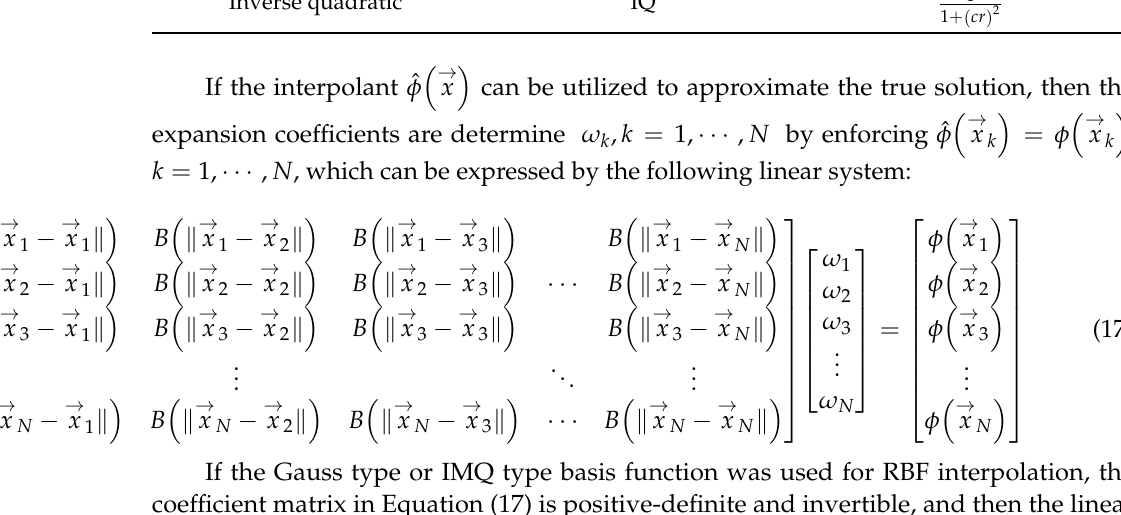
Table 1. Definitions of some infinitely differentiable radial functions, the shape parameter c controls their flatness. Name of RBF Abbreviation Definition Gaussian GA e − ( cr ) 2 Multiquadric MQ Inverse multiquadric IMQ Inverse quadratic